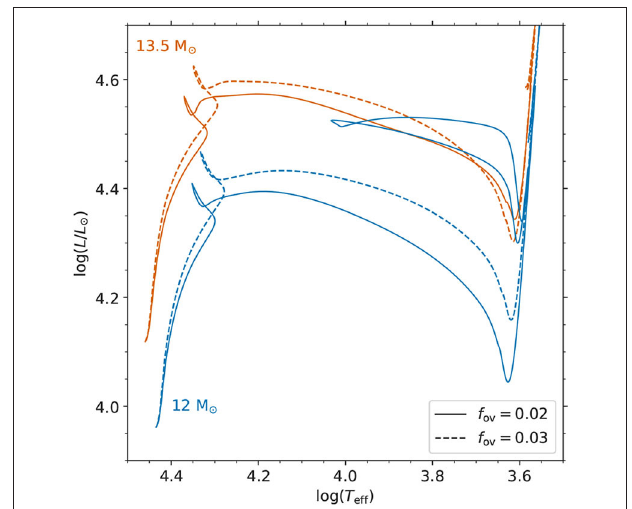
FIGURE 5 | HR diagram containing non-rotating evolutionary tracks starting from the zero-age main-sequence for stars of initial masses of 12- and 13.5-M calculated using the MESA stellar evolution code (Paxton et al., ⊙ 2019), using two different values for the diffusive exponential convective core-overshooting value ( f ov ), which are expressed in pressure scale heights. With increased mixing in the near-core region, a massive star has a longer main-sequence lifetime and produces a larger convective core mass at the terminal age main-sequence. The increased core mass and interior mixing during the main sequence phase of evolution also impacts the post-main sequence evolution of a massive star, including whether it performs a “ blue loop ,” which is demonstrated by the evolutionary track of the 12-M f ov =